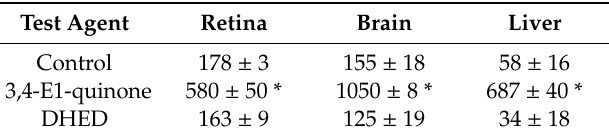
Table 2. Rates of H 2 O 2 production (nmol · h − 1 · mg protein − 1 , mean ± SD) at 37 ◦ C in selected tissue homogenates (0.2%, w / v , pH 7.4) of OVX rats in the absence and presence of the prooxidant E2 metabolite, 3,4-E1Q and DHED (100 µ M, respectively). * indicates statistically significant di ff erences (ANOVA followed by post hoc Dunnett’s test, p < 0.05) from the respective controls. Adopted with permission from reference [57]; copyright Elsevier